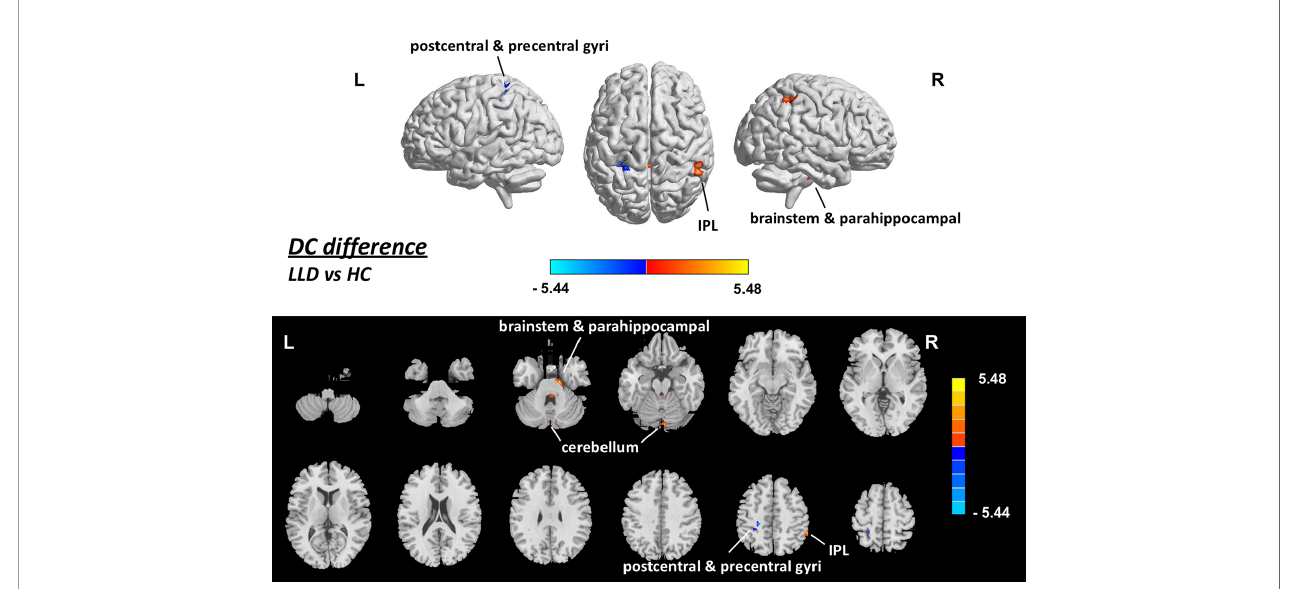
FIGURE 2 | Brain areas showing difference in DC between LLD patients and HCs ( p < 0.05, corrected), with gender, age, education, score on MMSE and framewise displacement regressed out. Upper: rendering views. Lower: axial slice views. Color bars indicate T -score; a warm color indicates areas where DC value in LLD patients > DC value in HCs, a cold color indicates areas where DC value in LLD patients < DC value in HCs. DC, degree centrality; HC, healthy control; IPL, inferior parietal lobule; L, left; LLD, late-life depression; R, right.